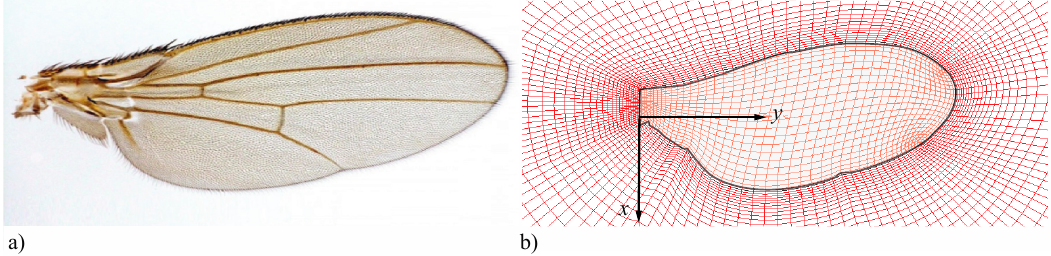
Figure 2. Images of ( a ) a fruit fly wing and ( b ) the corresponding 3D wing grid.